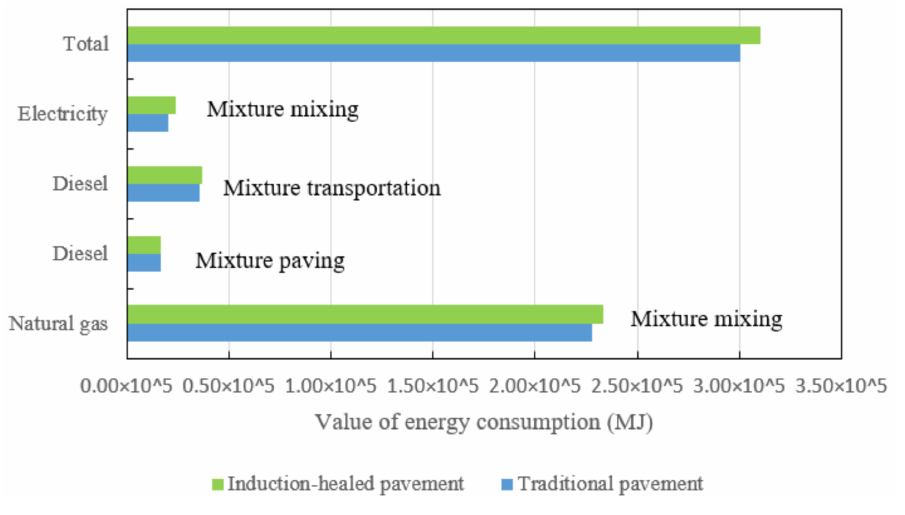
Figure 4. Energy consumption comparison of two asphalt pavement paving